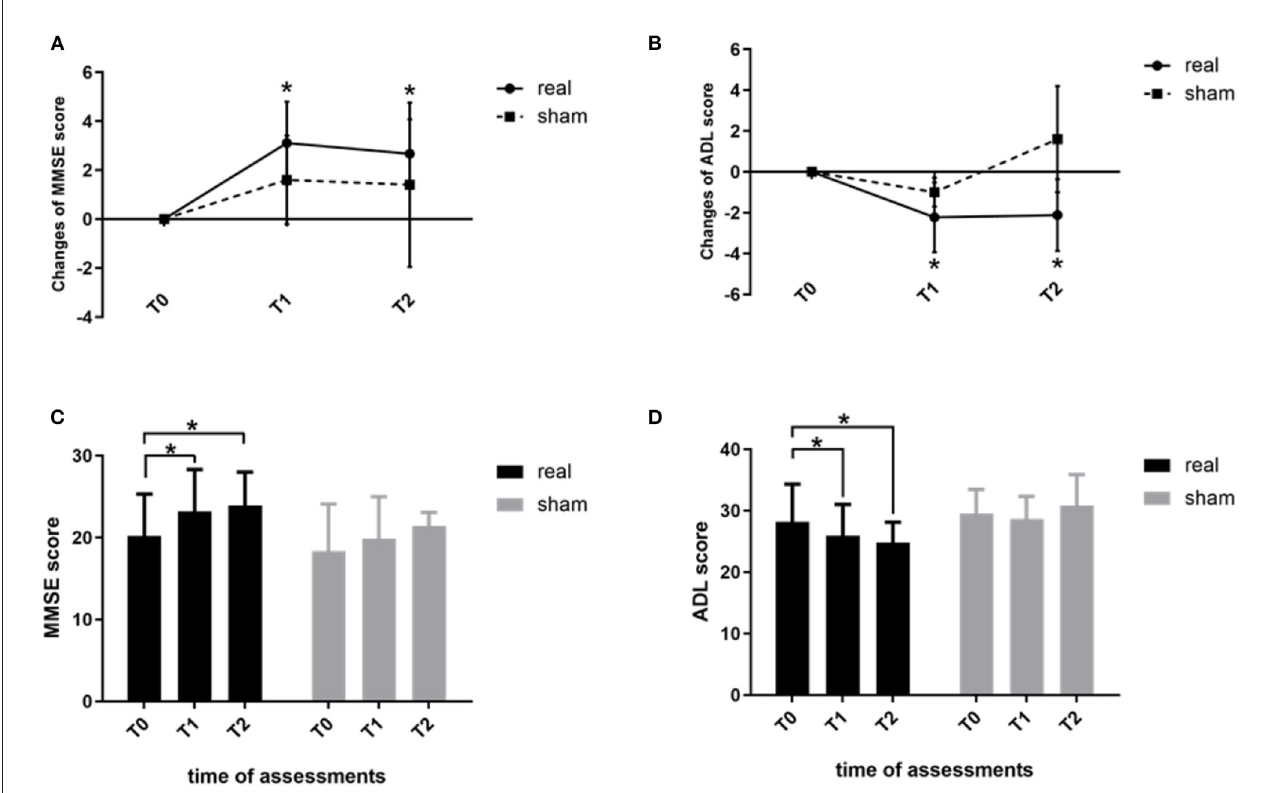
FIGURE1 Changes in the MMSE (A) and ADL (B) scores immediately after treatment (T1) and at 4 weeks after treatment (T2) from baseline measurements (T0). (C) shows MMSE scores and (D) shows ADL score within the two groups at the three time points (T0, T1, T2). MMSE, Mini-Mental State Examination; ADL, activities of daily living. * p < 0.05. Error bars indicate SD.